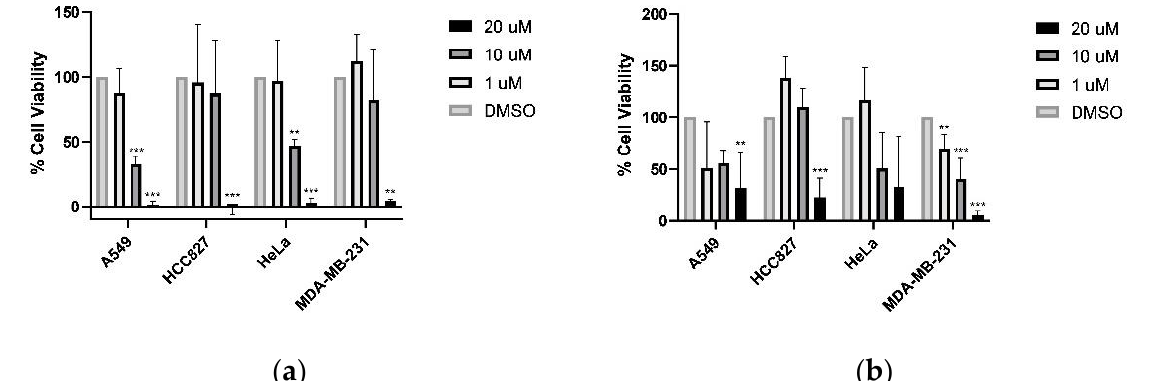
Figure 3. Viability studies using compound 5 ( a ) and compound 6b ( b ).